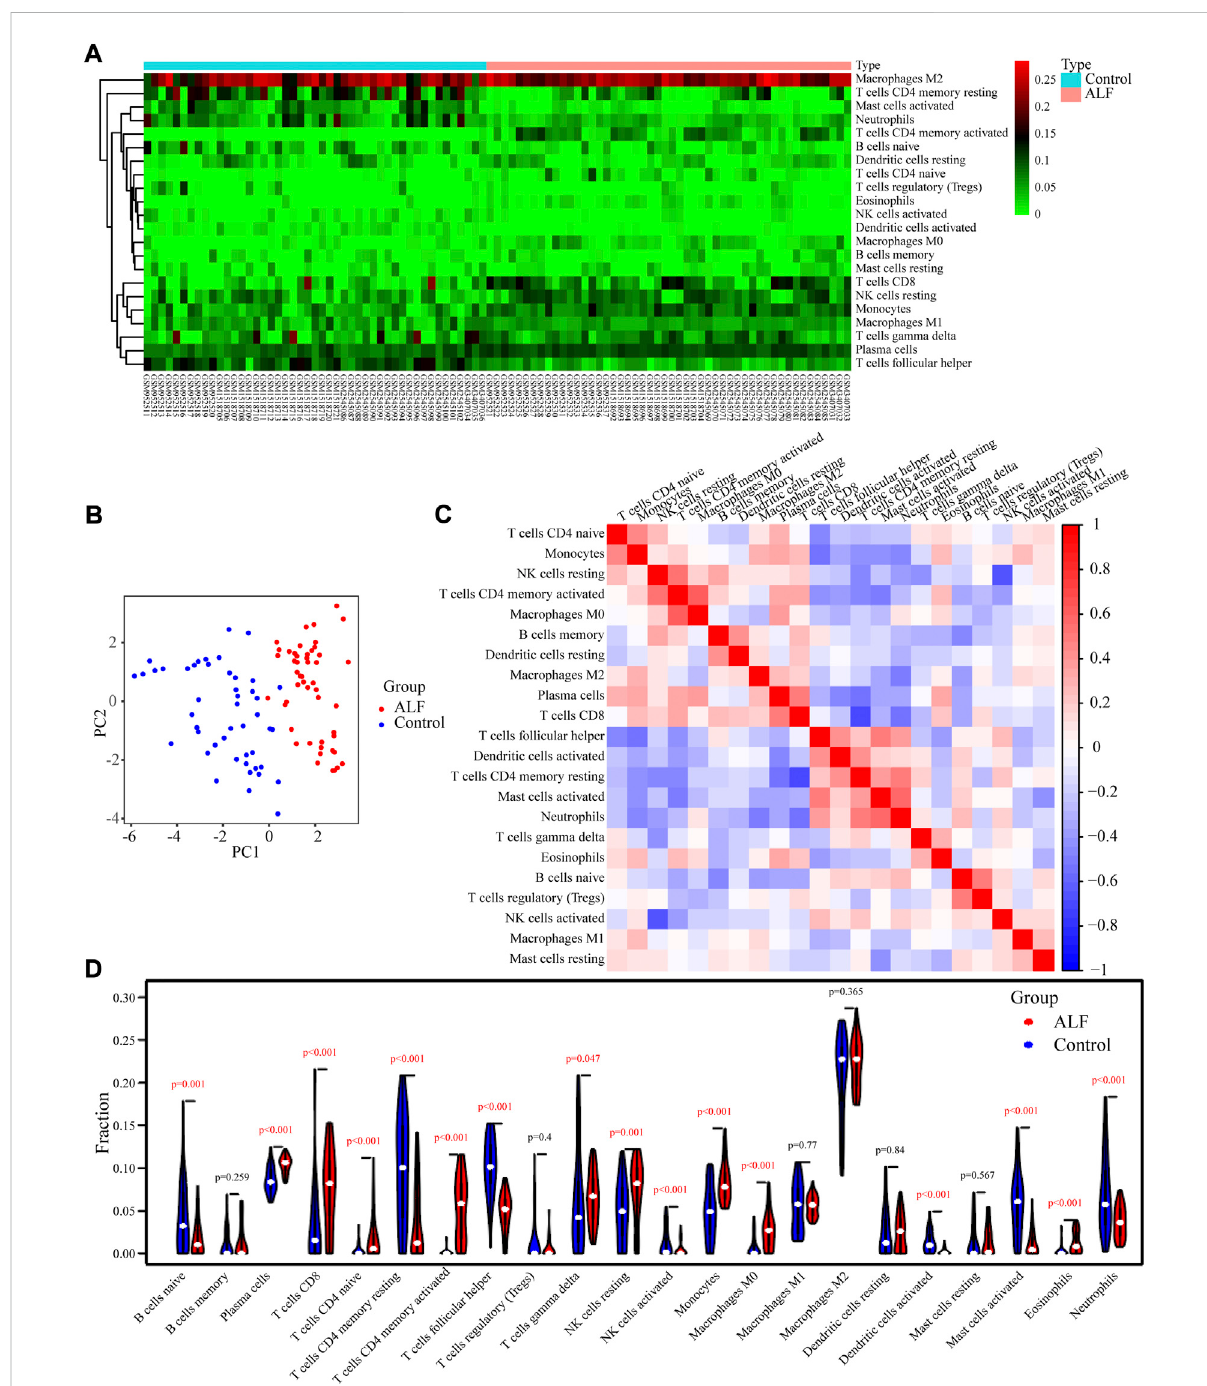
FIGURE 6 Characteristics of in fi ltrating immune cells. (A) Proportions of 22 immune cell subpopulations in normal and tissues. (B) PCA showed that 22 types of immune cells could roughly distinguish between and normal tissues. (C) Correlation coef fi cient heat map visualizing the interactions among immune cells. (D) Violin plot showing the immune cells with differential in fi ltration ( p <